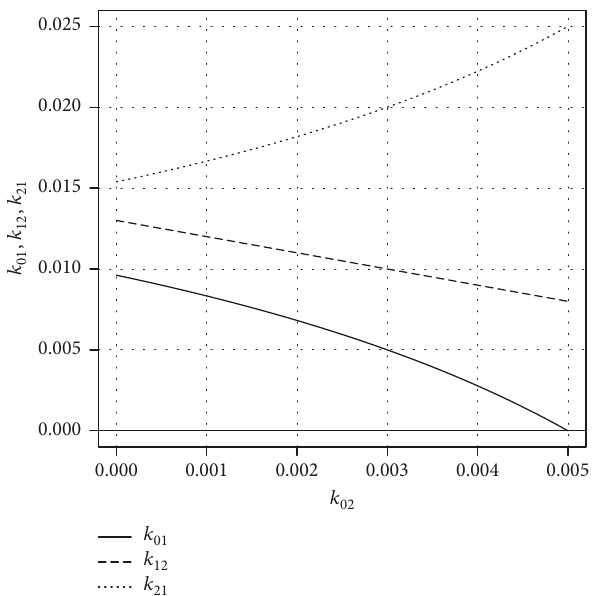
Figure 2: Equivalent parameterizations of 𝑘 01 , 𝑘 12 , and 𝑘 21 as functions of 𝑘 02 (see (15)).